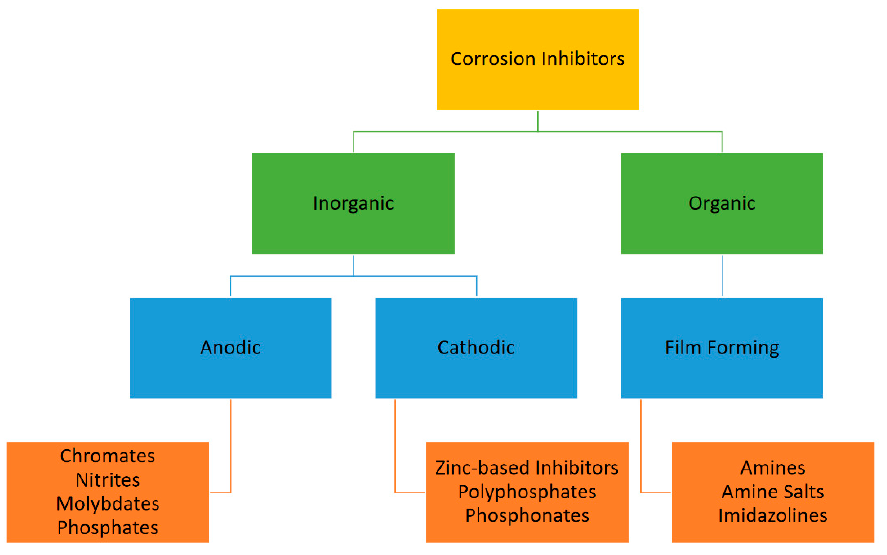
Figure 10. Types of corrosion inhibitors.